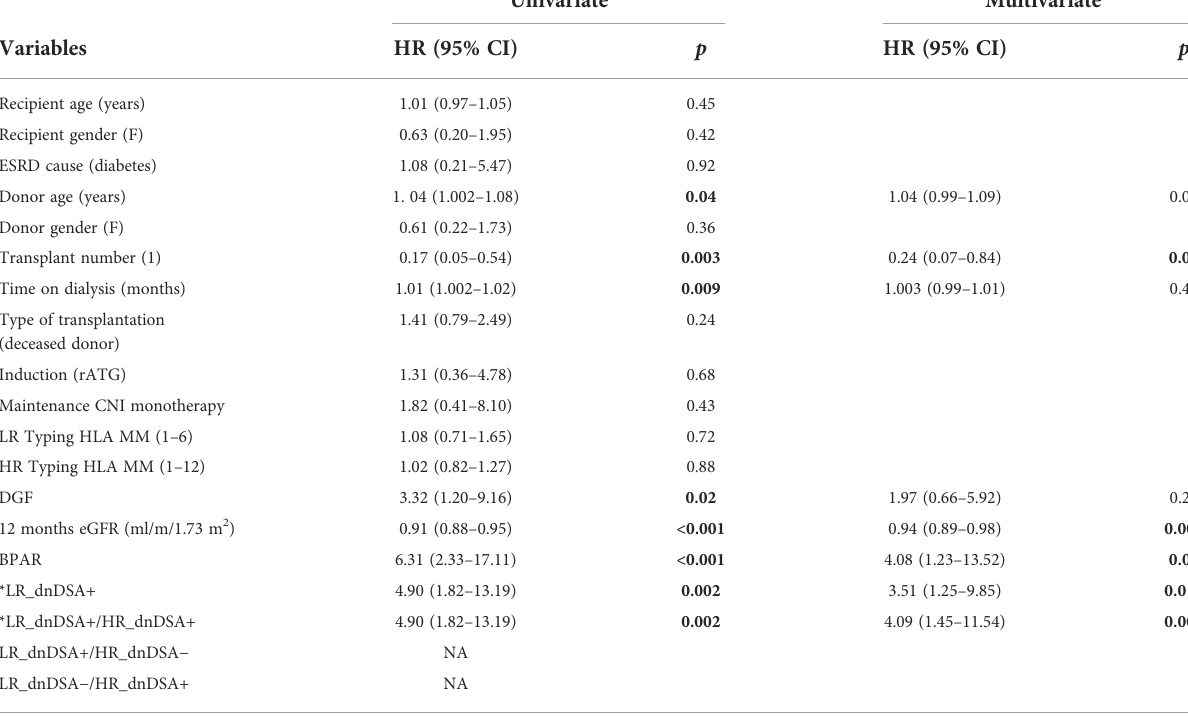
TABLE 5 Univariate and multivariate Cox regression analysis for death-censored graft loss.